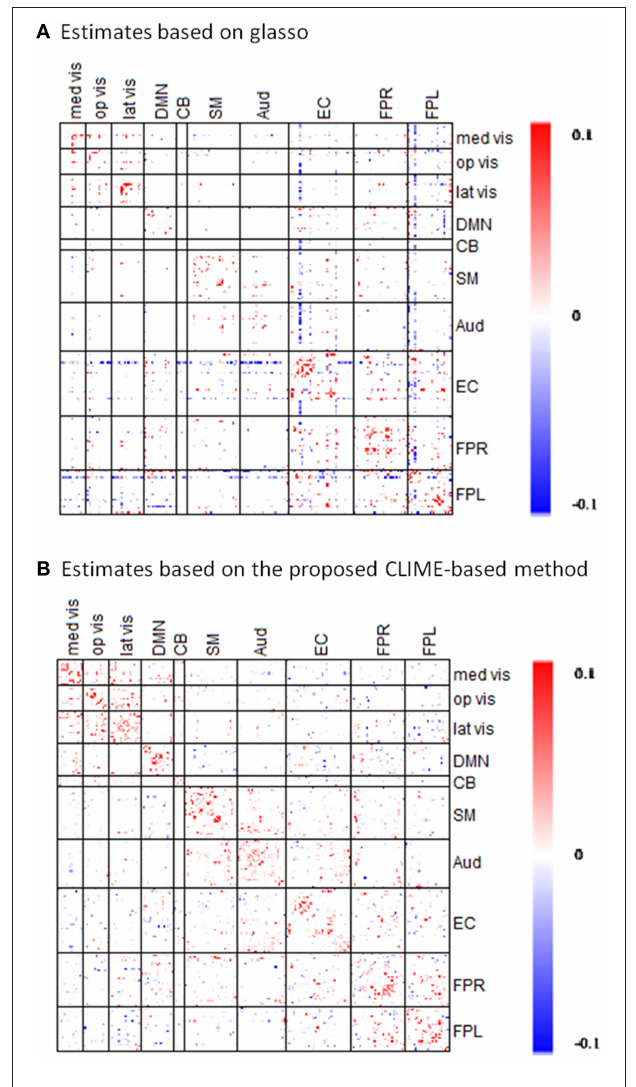
FIGURE 6 | Comparisons of partial correlation estimates based on the proposed CLIME-based method and based on GLASSO method. The symmetric 232 232 partial correlation matrices are estimated via the (A) × existing GLASSO approach and the (B) proposed CLIME-based approach using rs-fMRI data from a randomly selected subject in the PNC study. Sparsity regularization was set at similar level in both methods. Red indicates the positive edges and blue indicates the negative edges.